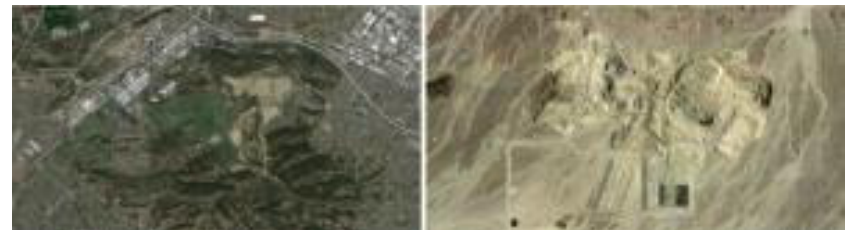
Figure 4. Los Angeles municipal waste previously sent to La Puente Hills Landfill (upper left), is now shipped 200 miles away to the newly opened Mesquite Regional Landfill (upper right)